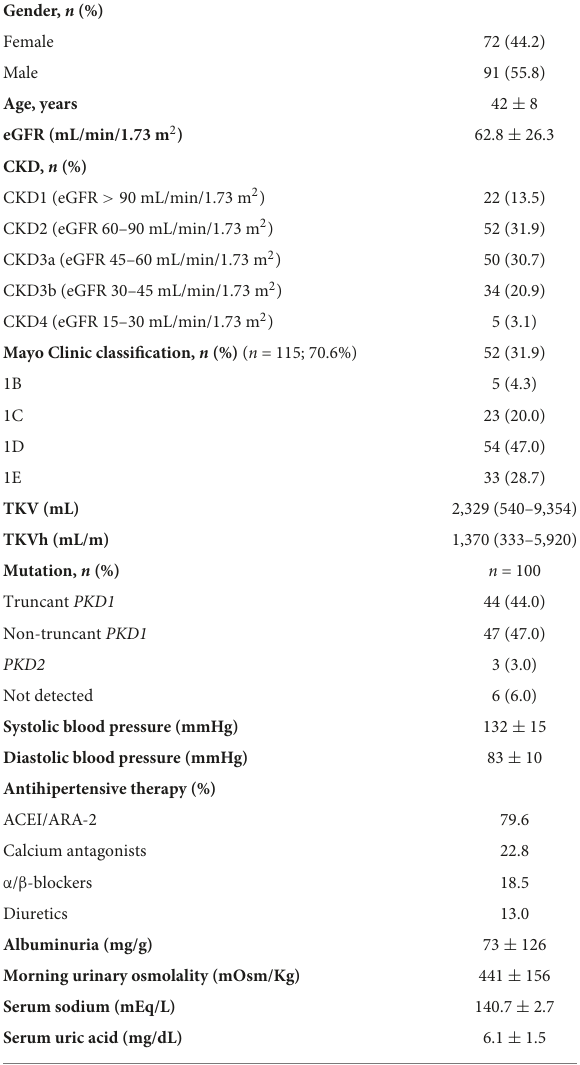
TABLE 1 Characteristics of study population before tolvaptan